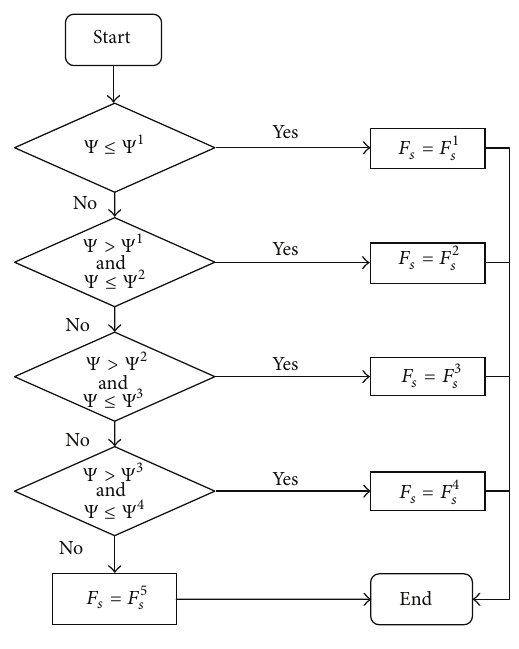
Figure 3: The flow chart of shear-tension coupling algorithm which runs for each membrane element at every time increment during a simulation.